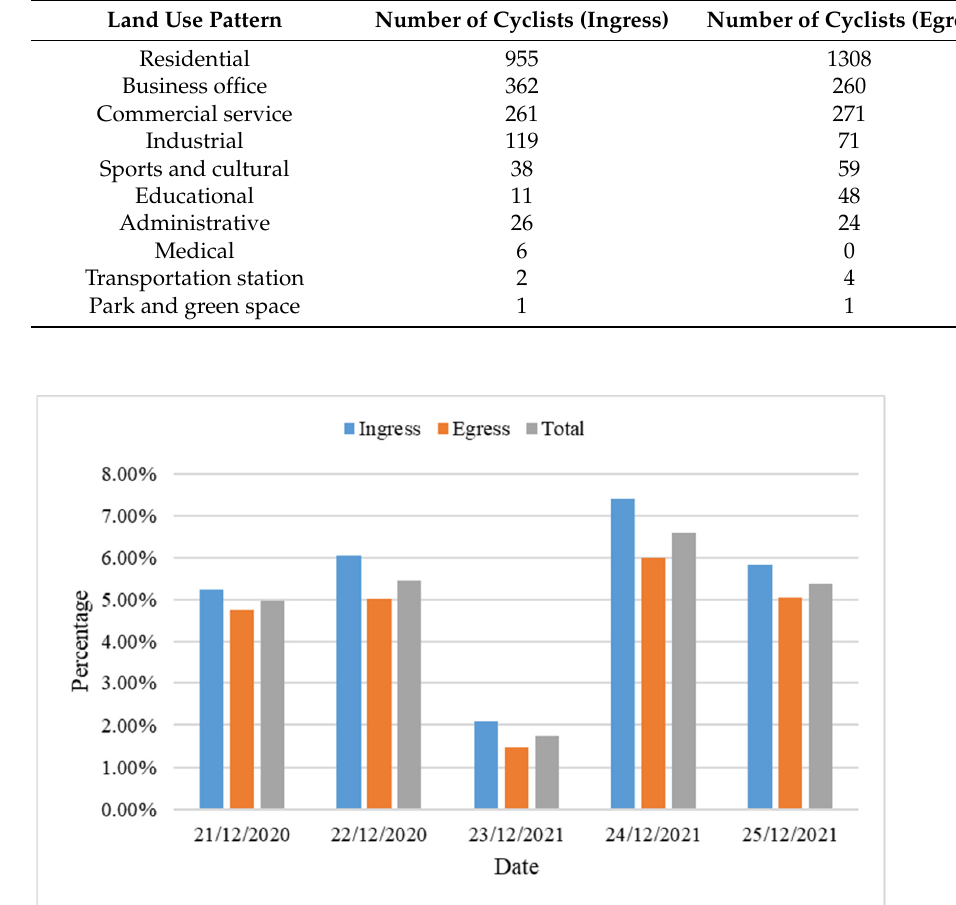
Figure 12. The fluctuation in cycling ratio for urban rail station ridership.